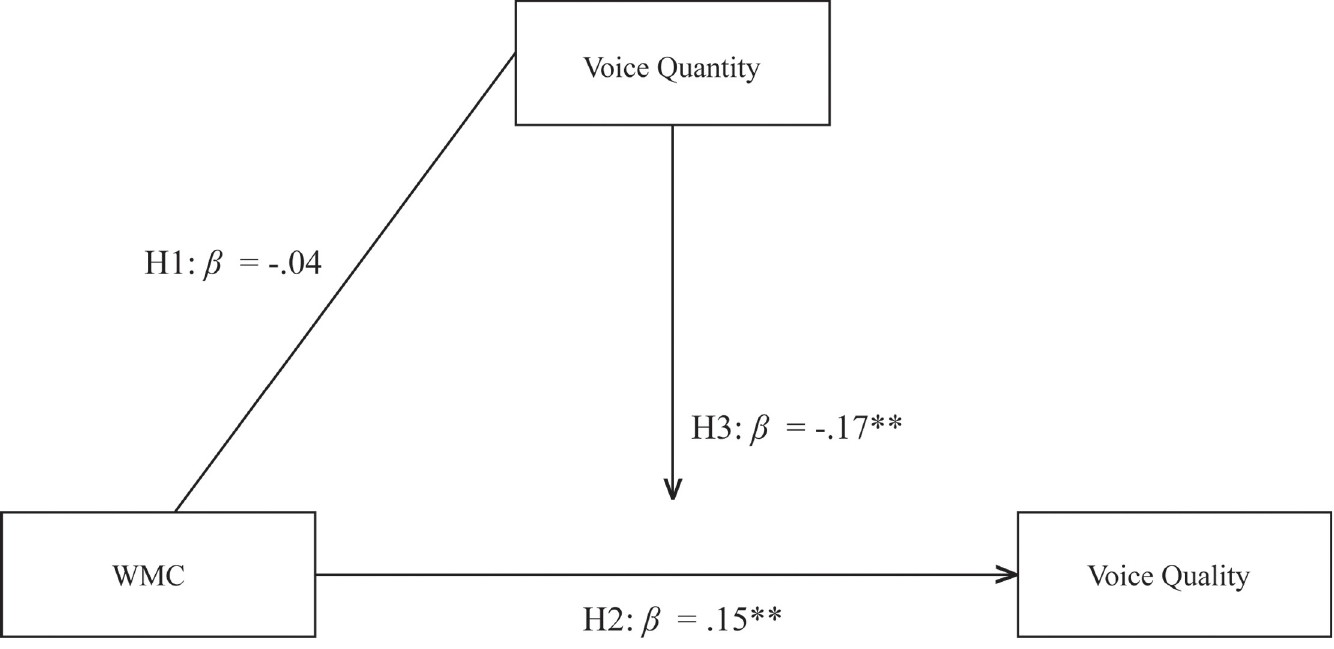
Fig 4. Model summary of all hypothesized effects study